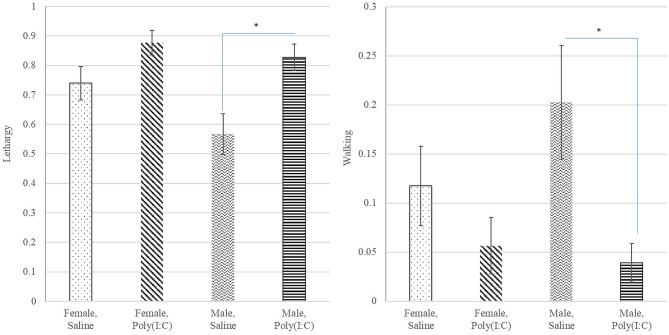
Probability of lethargy (left) and walking (right) behaviors (estimate and standard error of the mean) by Poly(I:C) treatment level (Saline or1 mg/kg) and sex (Female or Male). *Difference between treatment levels significant at P-value < 0.01 (n = 10).